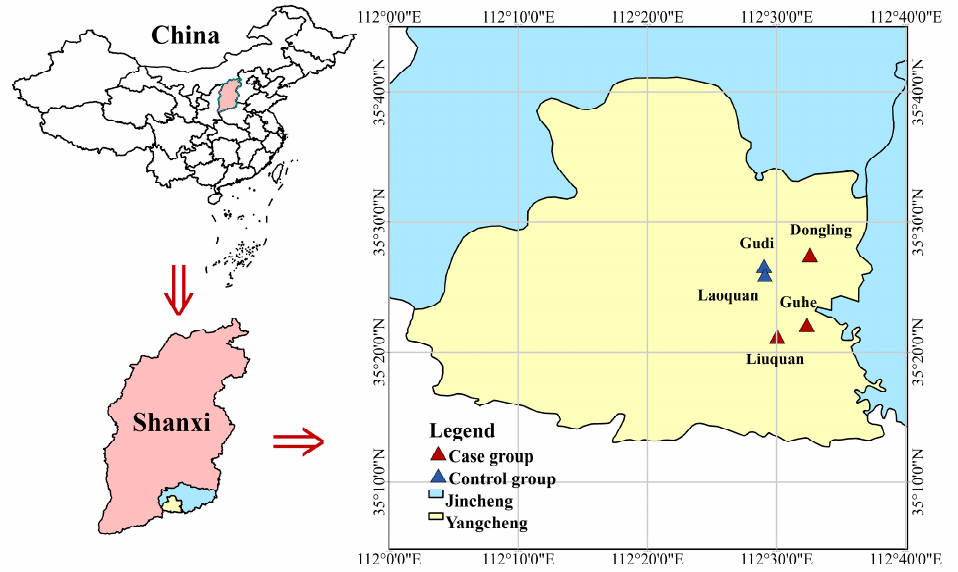
Figure 1. Location of study areas and sampling site.